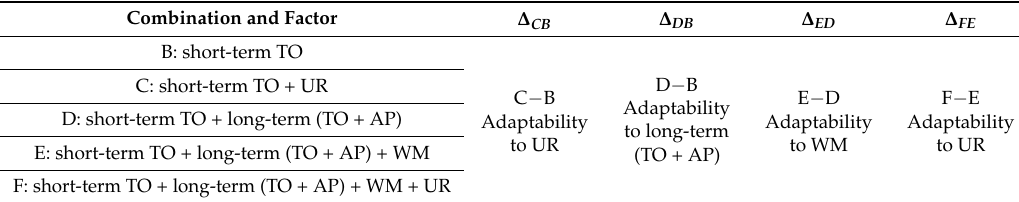
Table 4. Adaptability to environmental factors.